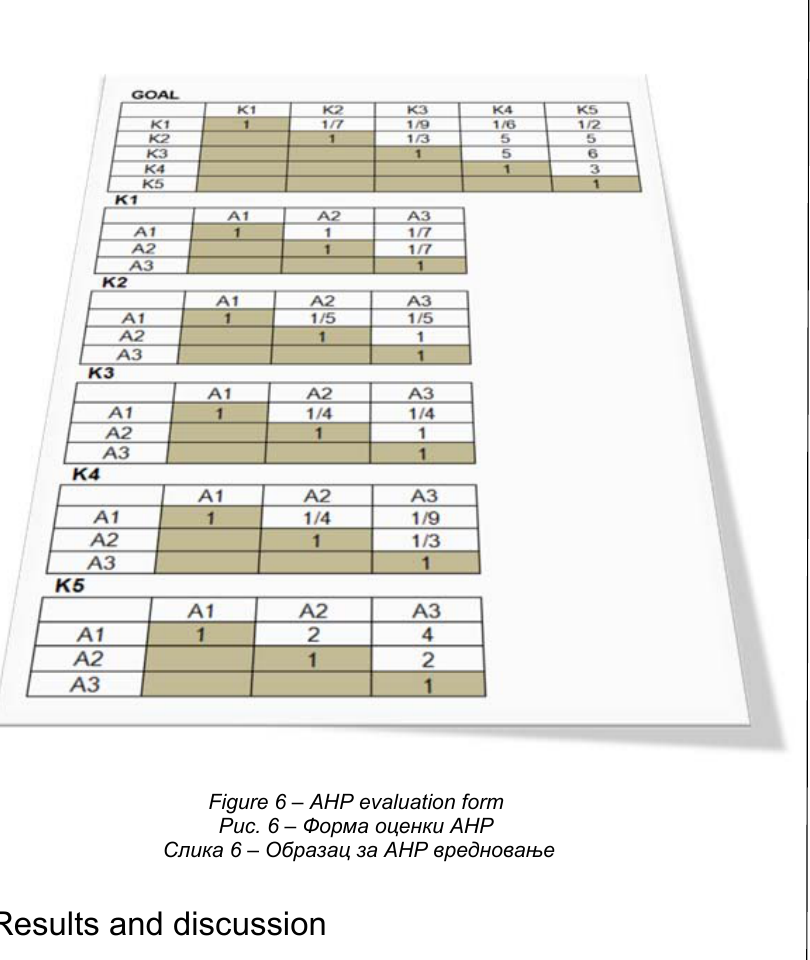
Figure 6 – AHP evaluation form Pu с . 6 – Форма оценки AHP Слика 6 – Образац за AHP